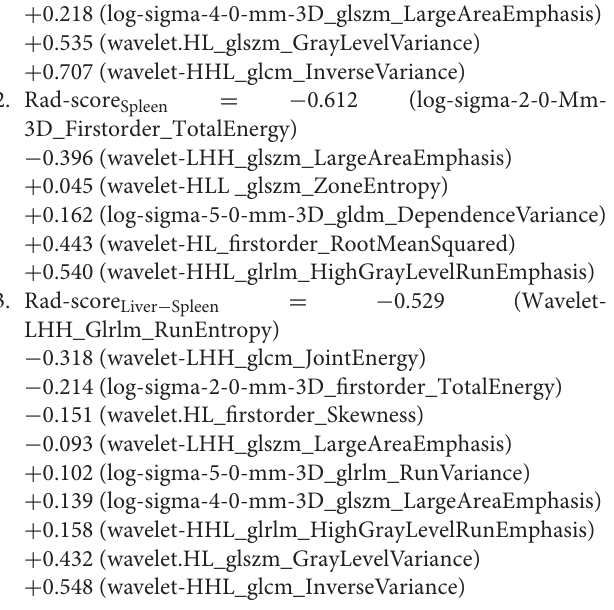
Figure 3 represents the process of features selected with non-zero coefficients in the LASSO Cox regression model in the training cohort. The ICCs of the selected features are also described in Supplementary Table 1